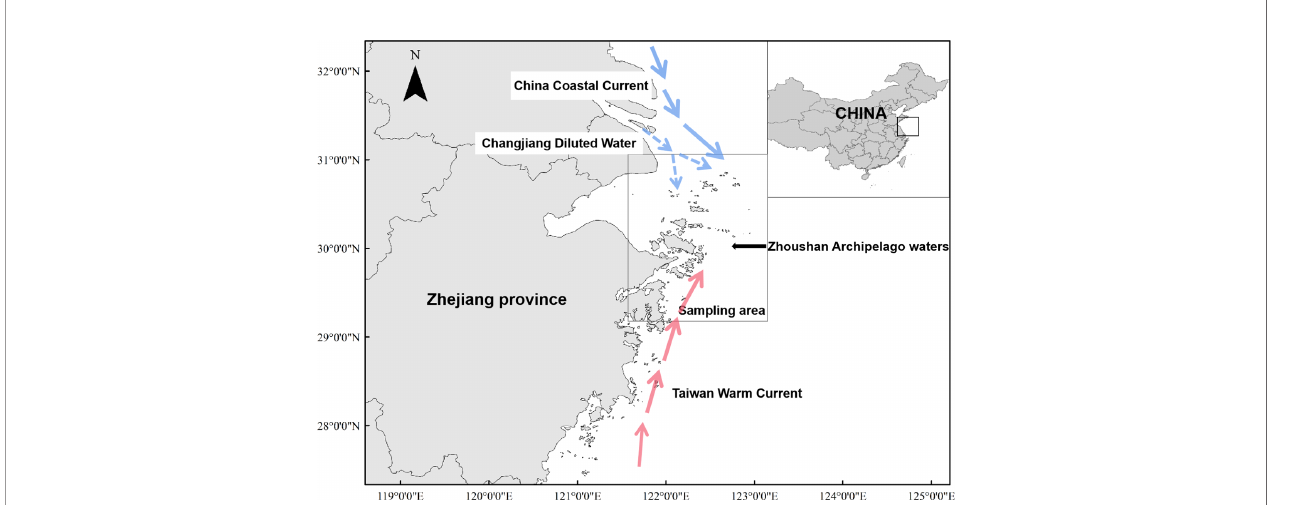
FIGURE 1 | Area of Zhoushan Archipelago where sciaenid fi sh species were collected between 2019 and 2021 for assessment of d 13 C and d 15 N